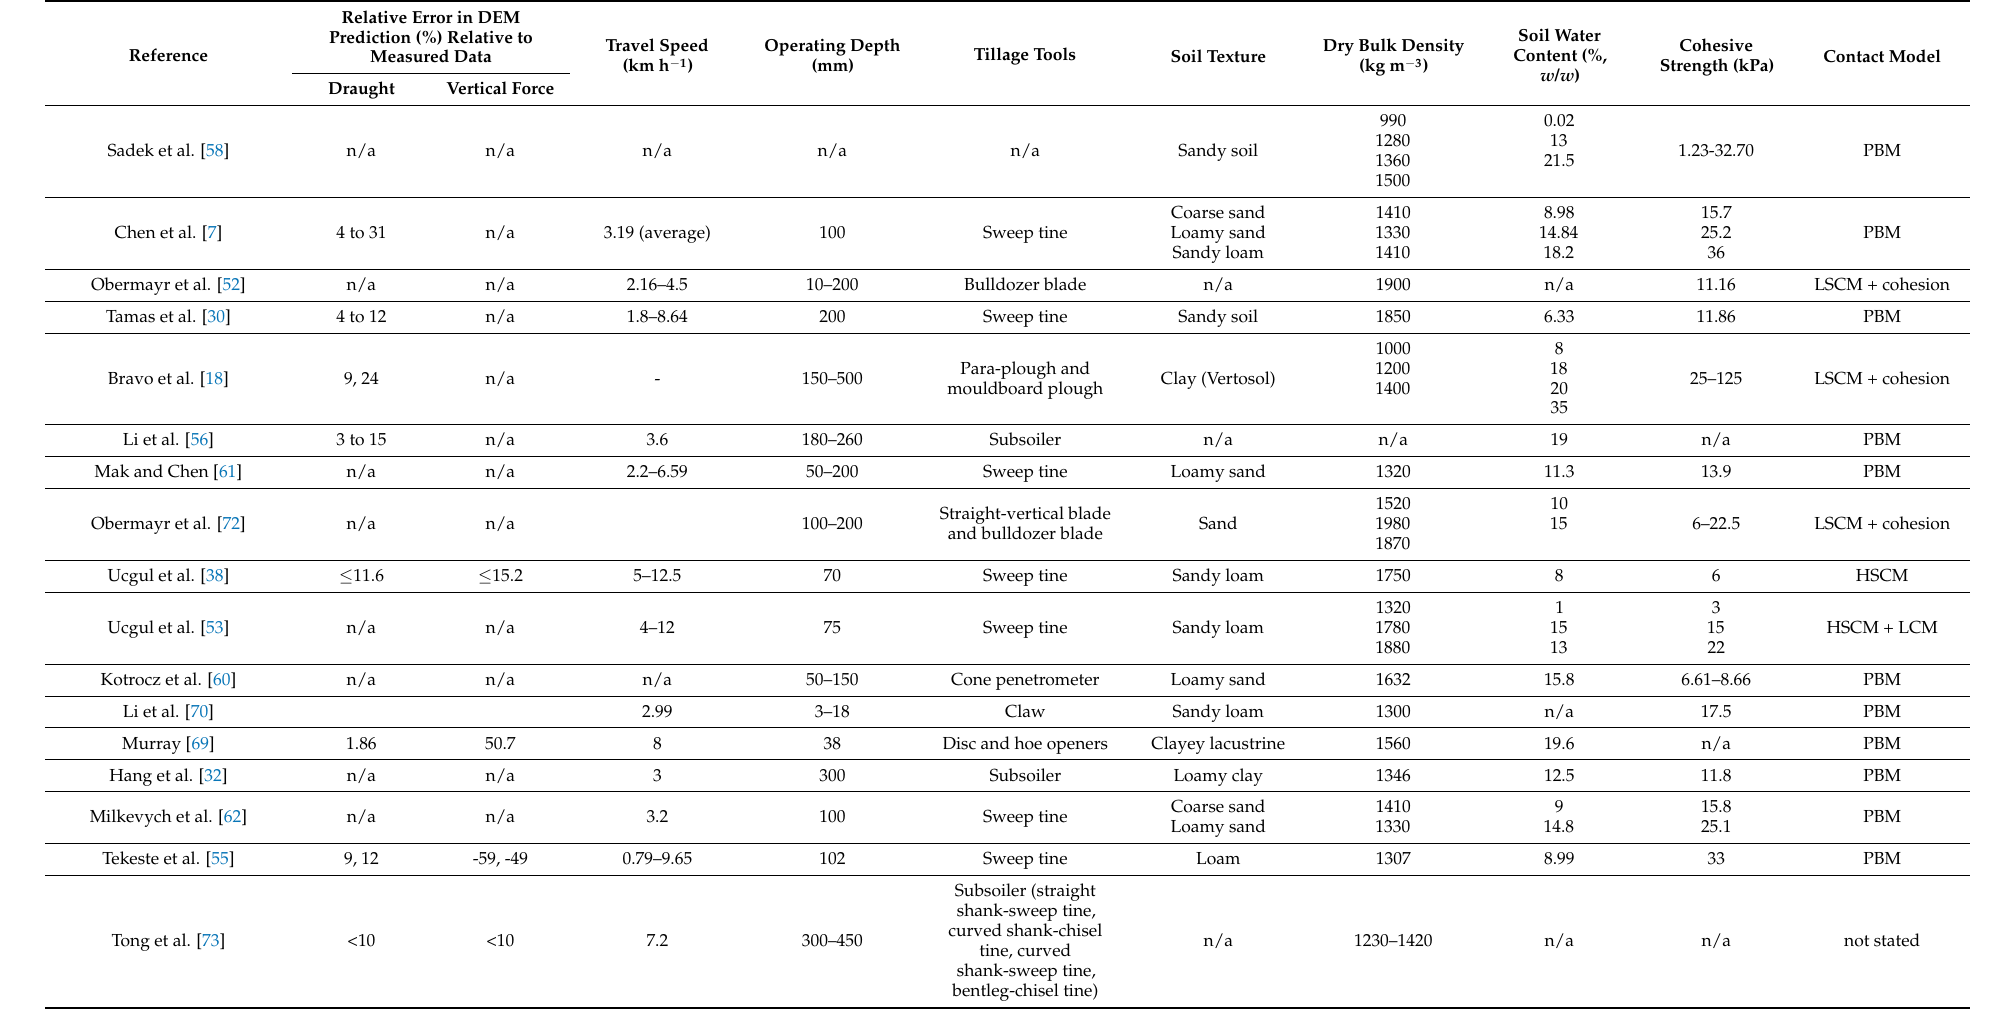
Table 2. Relative errors in DEM-predicted soil–tool reaction forces, travel speeds, and operating depths reported in the various literature across soil